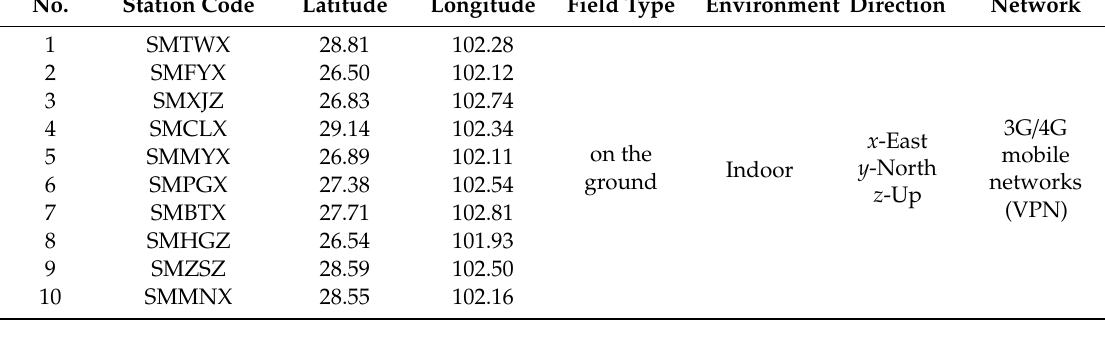
Table 2. Detailed station information of the low-cost seismic sensor network.